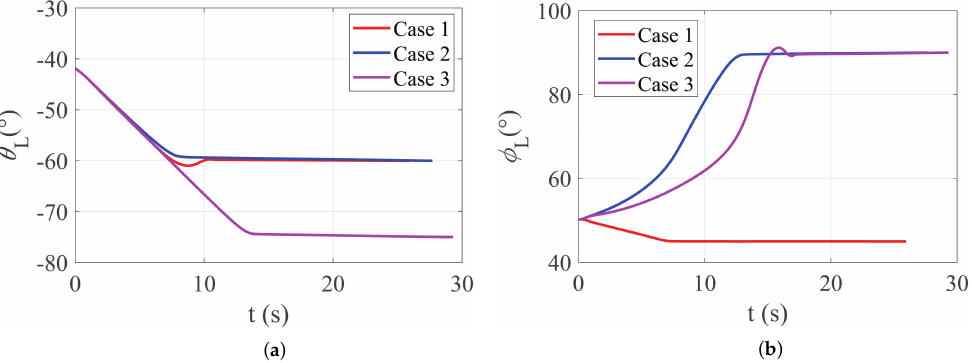
Figure 9. Variations of LOS angles against variable maneuvering targets: ( a ) LOS angles in pitch plane; ( b ) LOS angles in yaw plane.